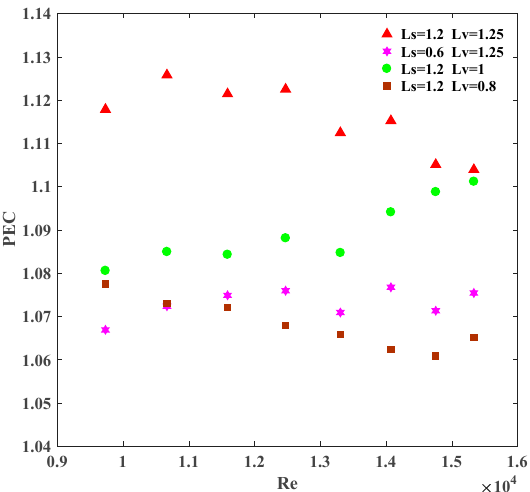
Figure 11. Performance evaluation criteria for different fin arrangements .